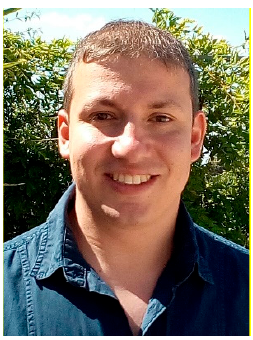
Figure 1. Dr. Giuseppe Ferrauto.